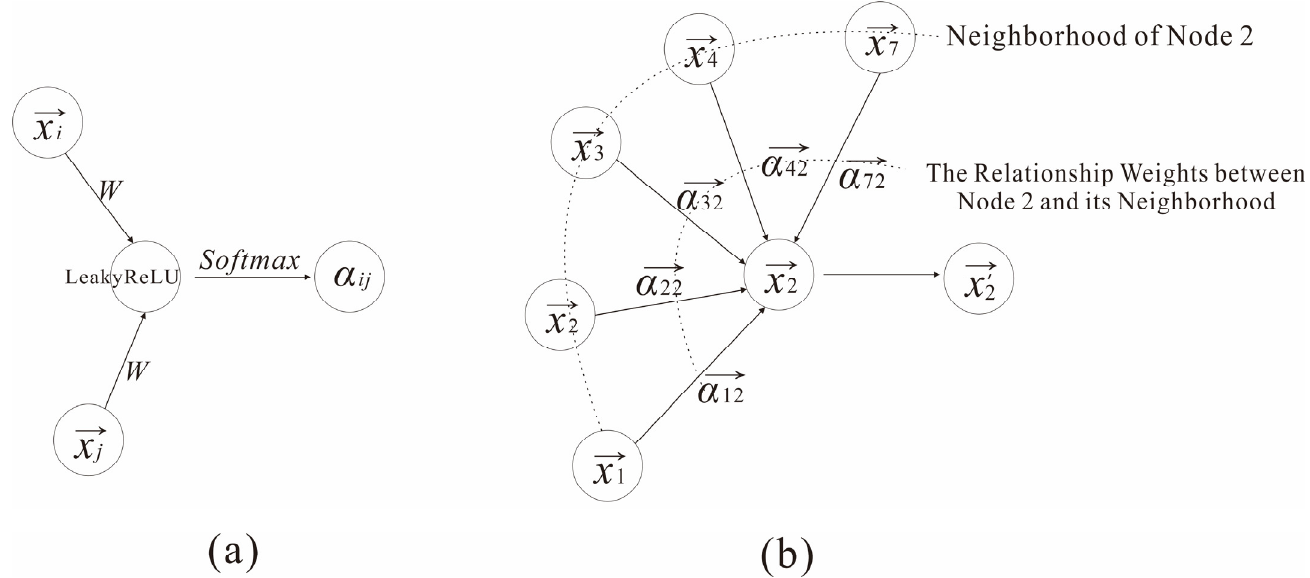
Figure 6. Illustration of the GAT layer (Modified after [24]): ( a ) how to determine the attention coefficient, corresponding to the Formula (3); ( b ) aggregating features of the node 2-based attention mechanism, with neighborhood {1,3,4,7}, corresponding to the Formula 4.